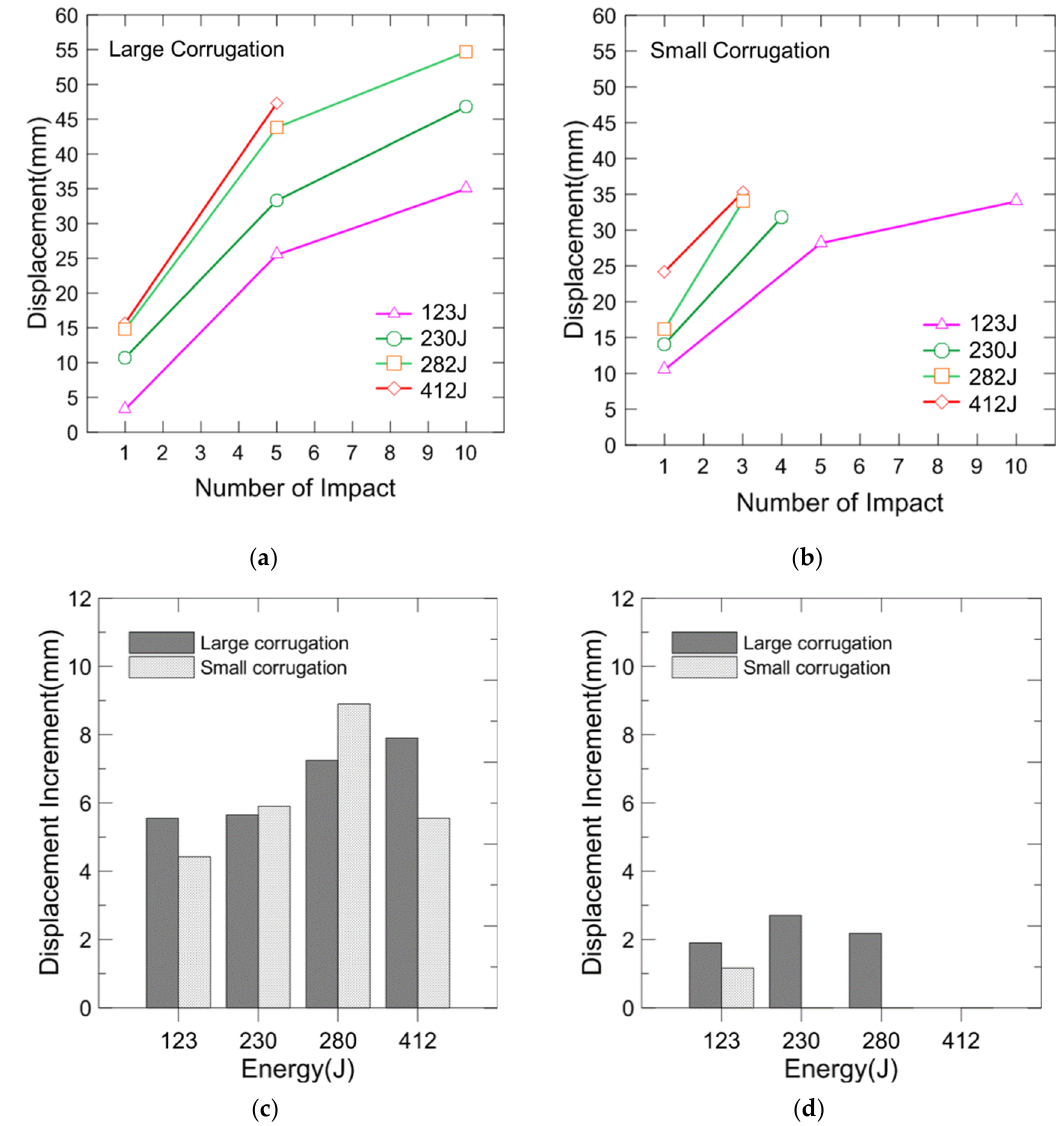
Figure 12. Displacement of ( a ) large corrugation and ( b ) small corrugation as the number of impacts increased and displacement increment of the specimens per the number of impacts ( c ) from the first to fifth and ( d ) from the sixth to tenth.